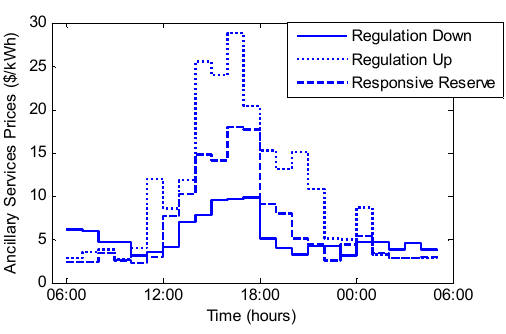
Figure 5. Hourly energy price.